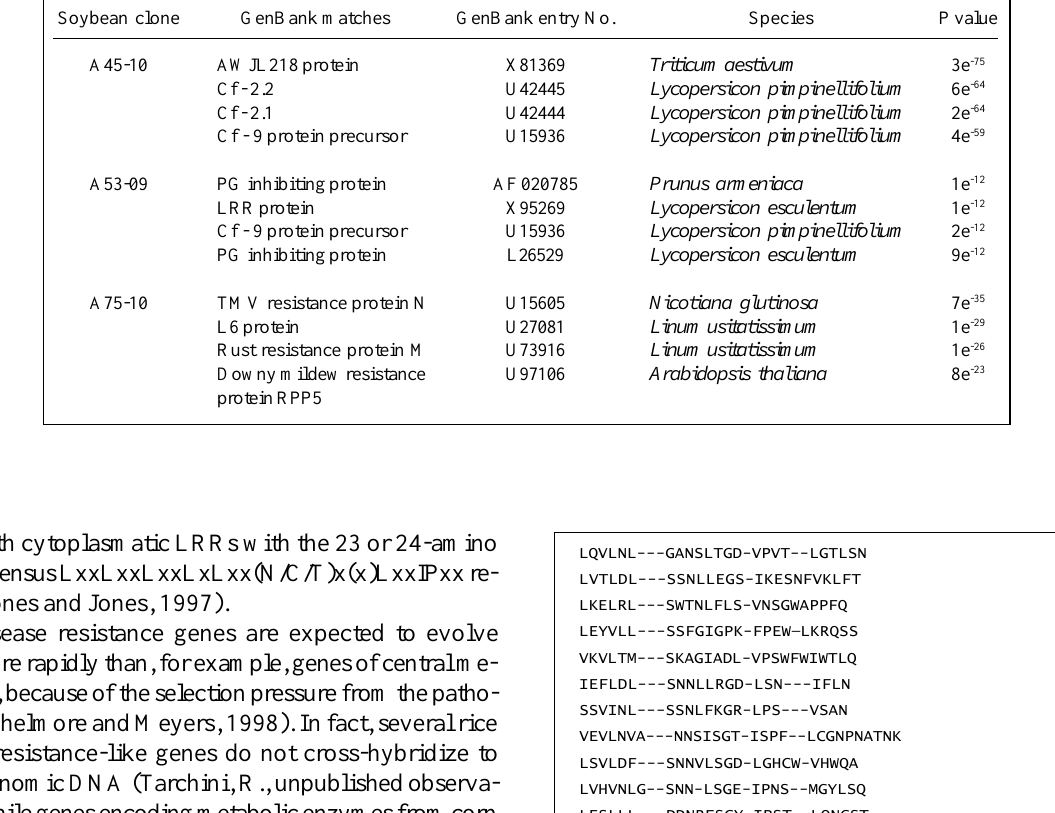
Table I - Blast analyses of amino acid sequences deduced from soybean RFLP clones A45-10, A53-09, and A75-10. Soybean clone GenBank matches